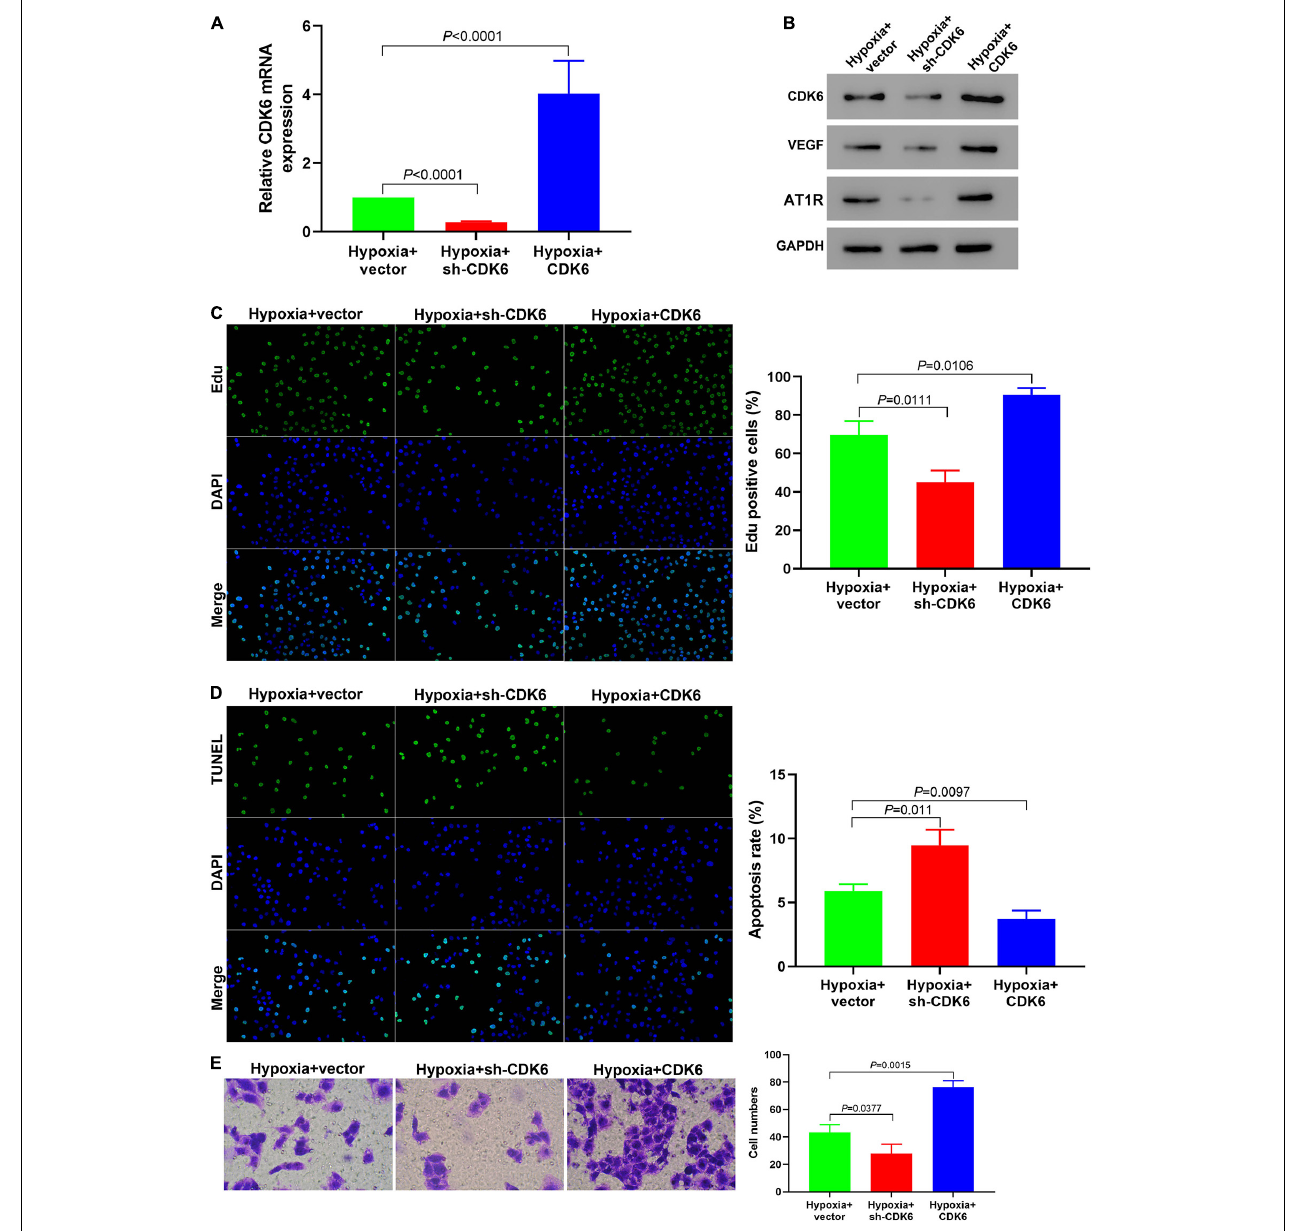
FIGURE 5 | Downregulation of CDK6 in vitro reverses the hypoxia-mediated promotion of cell proliferation and migration. (A) qRT-PCR indicating successful silencing and overexpression of CDK6 . (B) The protein expression of VEGF and AT1R was significantly decreased in hPASMCs treated with sh-CDK6. In contrast, they were elevated in cells treated with CDK6 overexpression vectors (all p < 0.01). (C–E) Edu assay (C) , TUNEL assay (D) , and Transwell assay (E) indicating that the cell proliferation and migration were decreased while the apoptosis rate of hypoxic PASMCs was elevated in the sh-CDK6 group under hypoxia, compared to the control group. Error bars represent the mean ± SD from triplicate experiments. Image magnification: ×